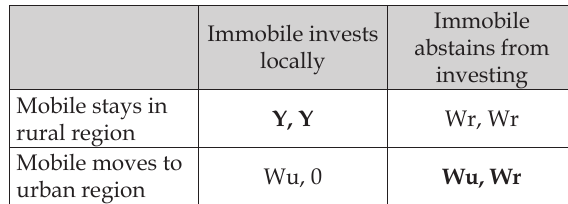
Fig. 1. The circle of declining rural regions. Source: adapted from OECD (2006).